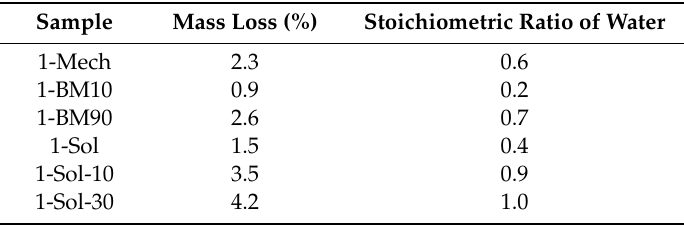
Table 2. Mass loss at 150 ◦ C determined by TGA with corresponding equivalence of H 2 O per